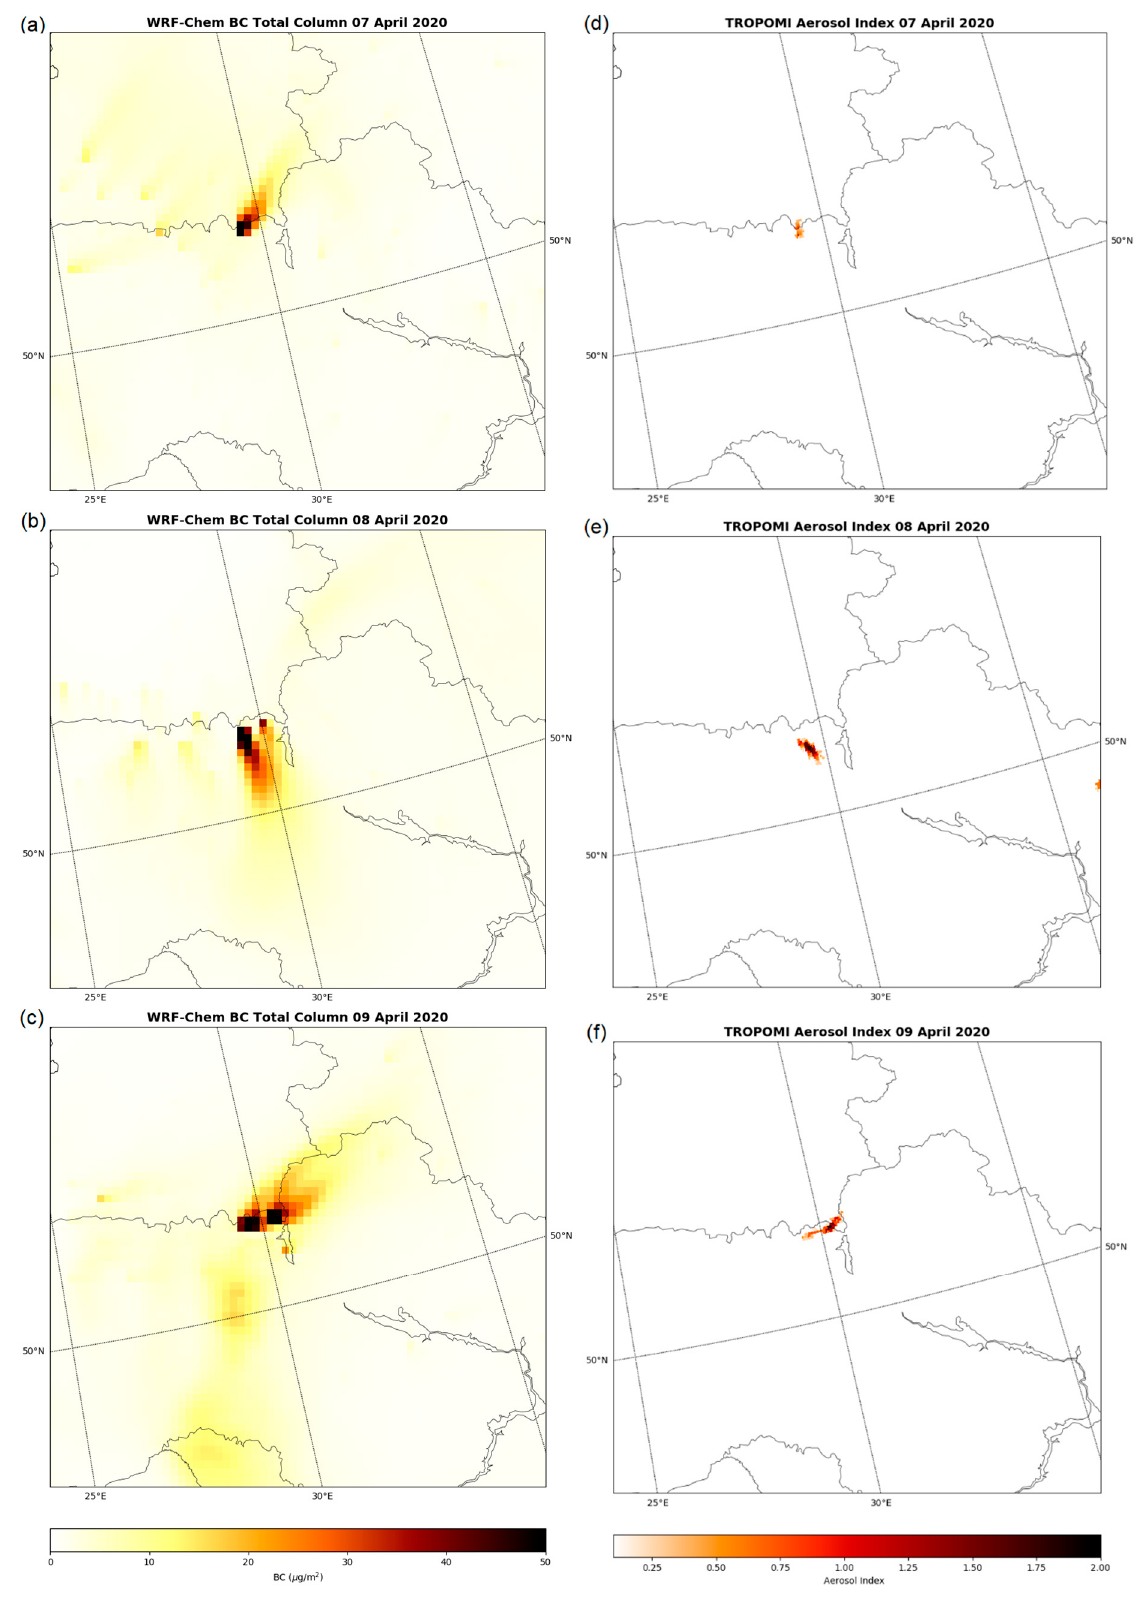
Figure 2. Simulated daily mean BC (µg/m 2 ) with WRF-Chem ( a – c ) and observed AI from TROPOMI ( d – f ) from the 7 to 9